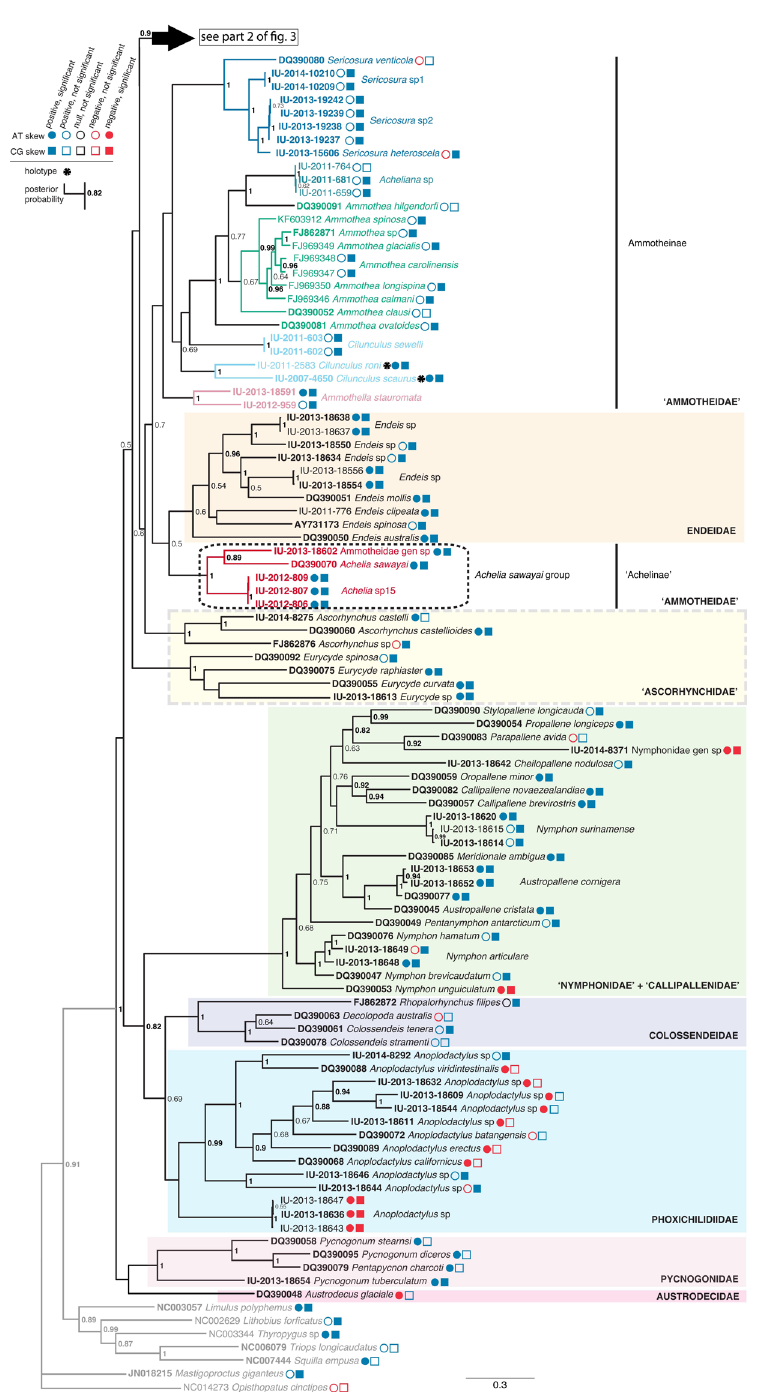
Fig. 3. Bayesian tree of Pycnogonida based on 179 sequences of the mitochondrial CO1 gene (partitioned analysis). Coloured rectangles show non-ammotheid families, and coloured branches discriminate ammotheid genera. The numbers at the nodes indicate posterior probabilities greater than 0.5. Symbols associated with each taxon name indicate the bias in base composition, as expressed by AT (circles) and CG (squares) skews (see main text for details): blue symbols represent a significant positive bias; red symbols indicate a significant negative bias; uncoloured symbols show insignificant values of skews. Asterisks after taxon names indicate holotype specimens. The arrow at the top of the tree shows the connection with Part 2 of the tree (see next